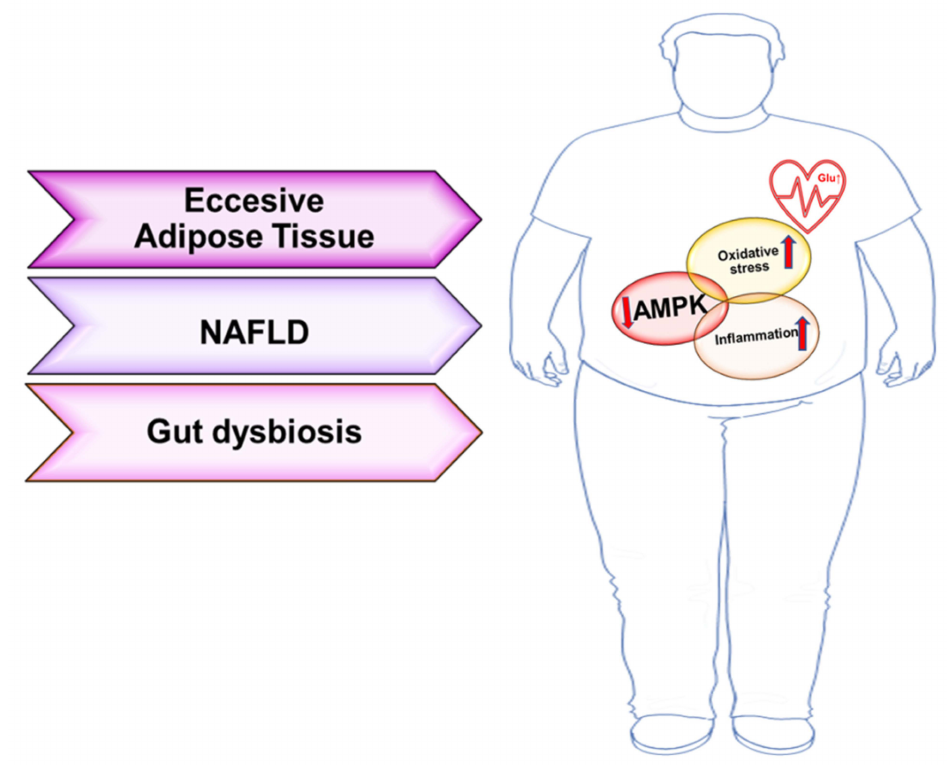
Figure 1. Schematic representation of the strong interconnection between T2DM and CVD. Excessive adipose depots, gut dysbiosis, and NAFLD are key risk factors that promote T2DM and CVD. At the molecular level, oxidative stress and inflammatory condition are the primary mediators of metabolic and cardiac damages. These processes are orchestrated by AMPK impaired signaling (modified by Servier Medical Art by Servier is licensed under a Creative Commons Attribution 3.0 Unported